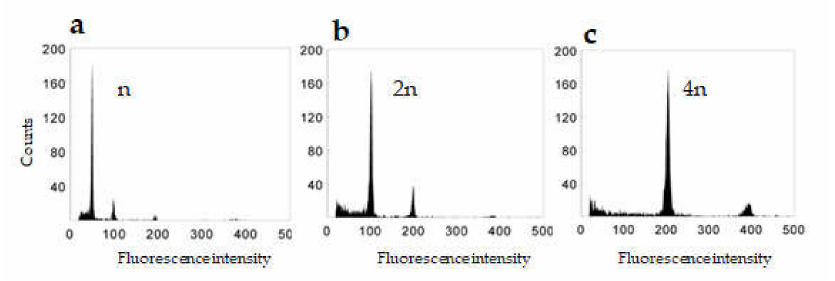
Figure 2. DNA content of nuclei isolated from leaves of transgenic plants regenerated from anthers ( a ) haploid plant ( n ), ( b ) dihaploid plant (2n), ( c ) tetrahaploid plant